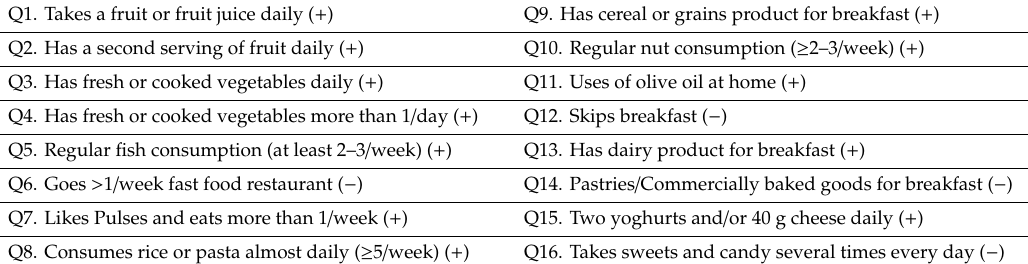
Table 1. Adherence to the Mediterranean Diet Questionnaire